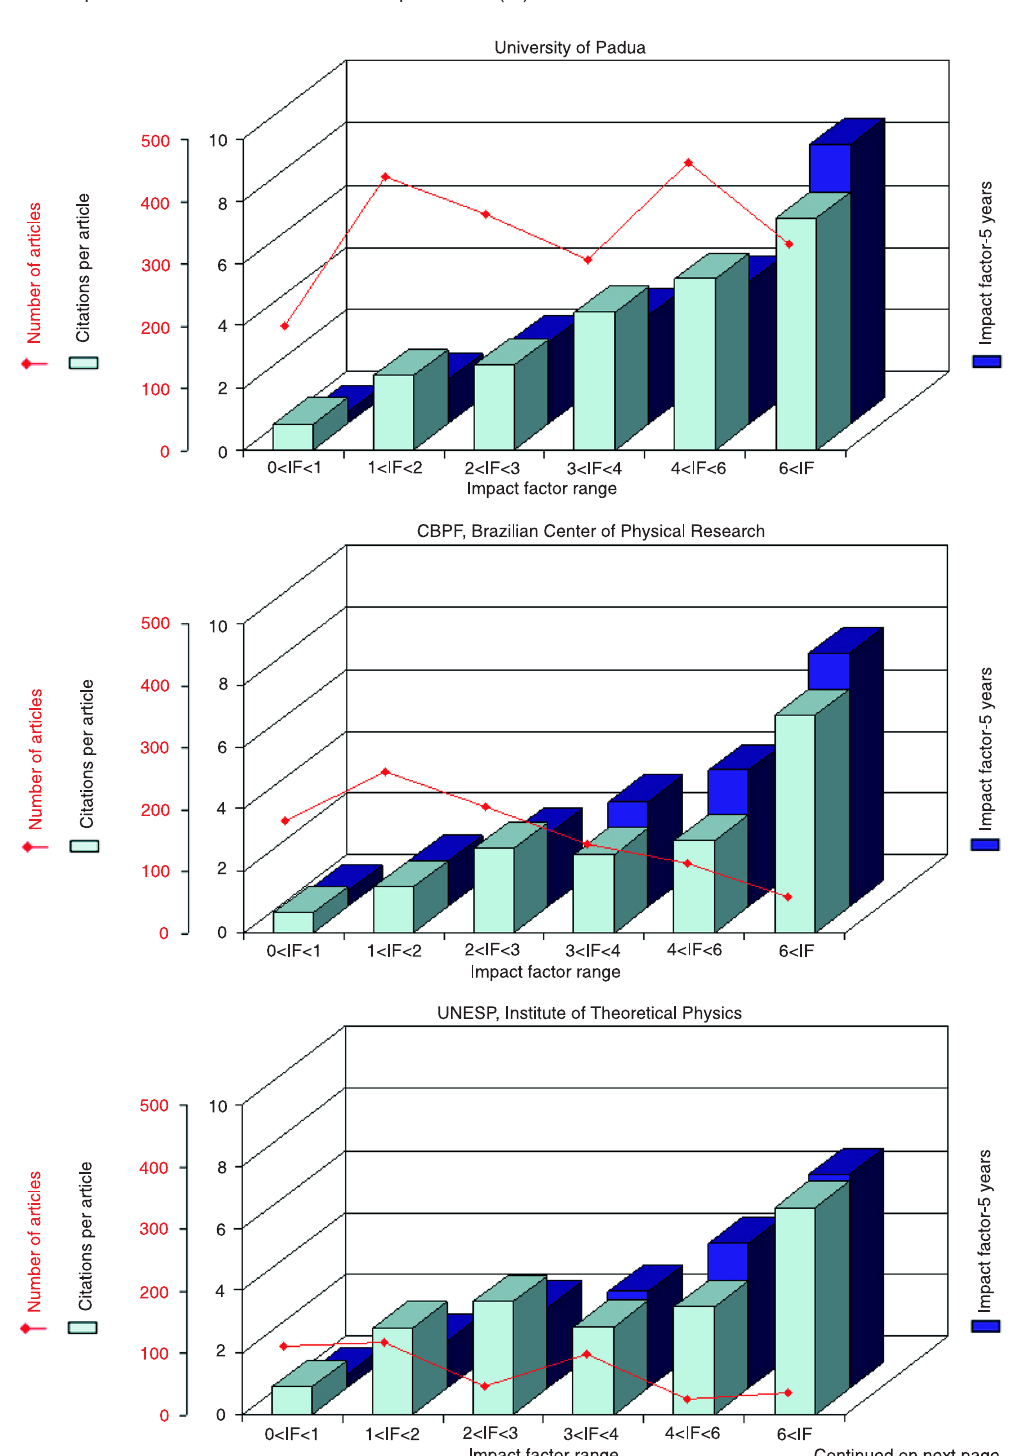
Figure 1. Number of articles (2003-2007), citations per article (2008), and 5-year impact factor (2008) for 12 institutions of Physics, 10 from Brazil plus the University of Padua and Princeton University. The three indicators were reported in terms of six intervals of impact factor